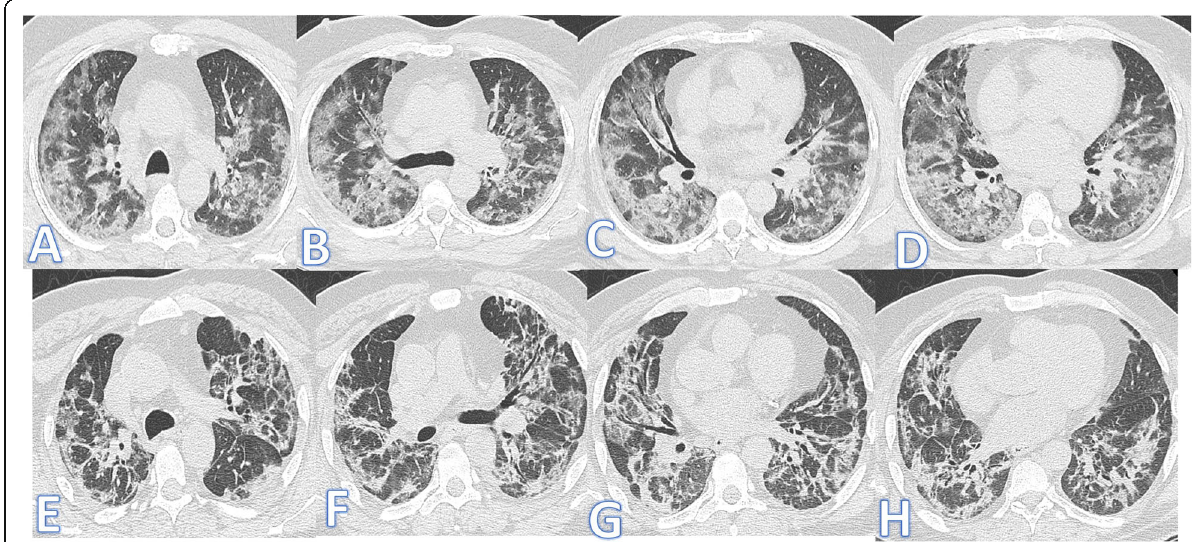
Fig. 7 Fifty-five-year-old male: he has DM, HTN, and IHD; peak CT severity score 16; consolidation/crazy-paving score 14. He was admitted to the ICU; laboratory results showed lymphopenia, high CRP, D -dimer, normal serum ferritin, and sensitivity troponin. Steroid was given; length of stay during hospitalization is 30days. Peak CT during admission ( a – d ) showed bilateral consolidation patches more peripheral and at the lower lobes with a crazy-paving appearance. Follow-up CT 3weeks after discharge ( e – h ) showed lung fibrosis with parenchymal bands, coarse reticular pattern, irregular interface, and mild traction bronchiectasis at the anterior segments of both upper lobes and the medial segment of the right middle